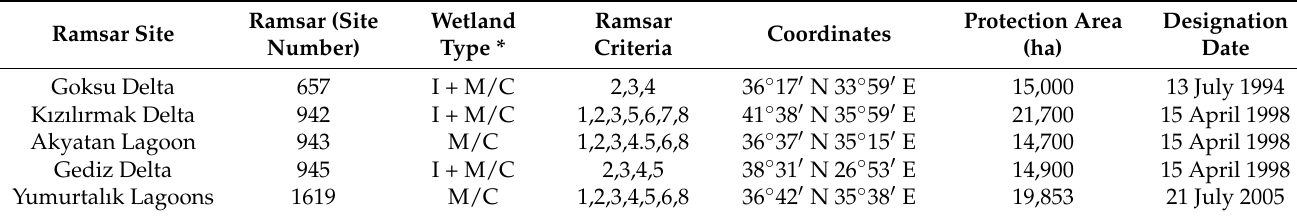
Figure 1. Turkey’s Ramsar sites and nearby meteorological stations (for coastal/marine sites). Table 1. Coastal Ramsar sites of